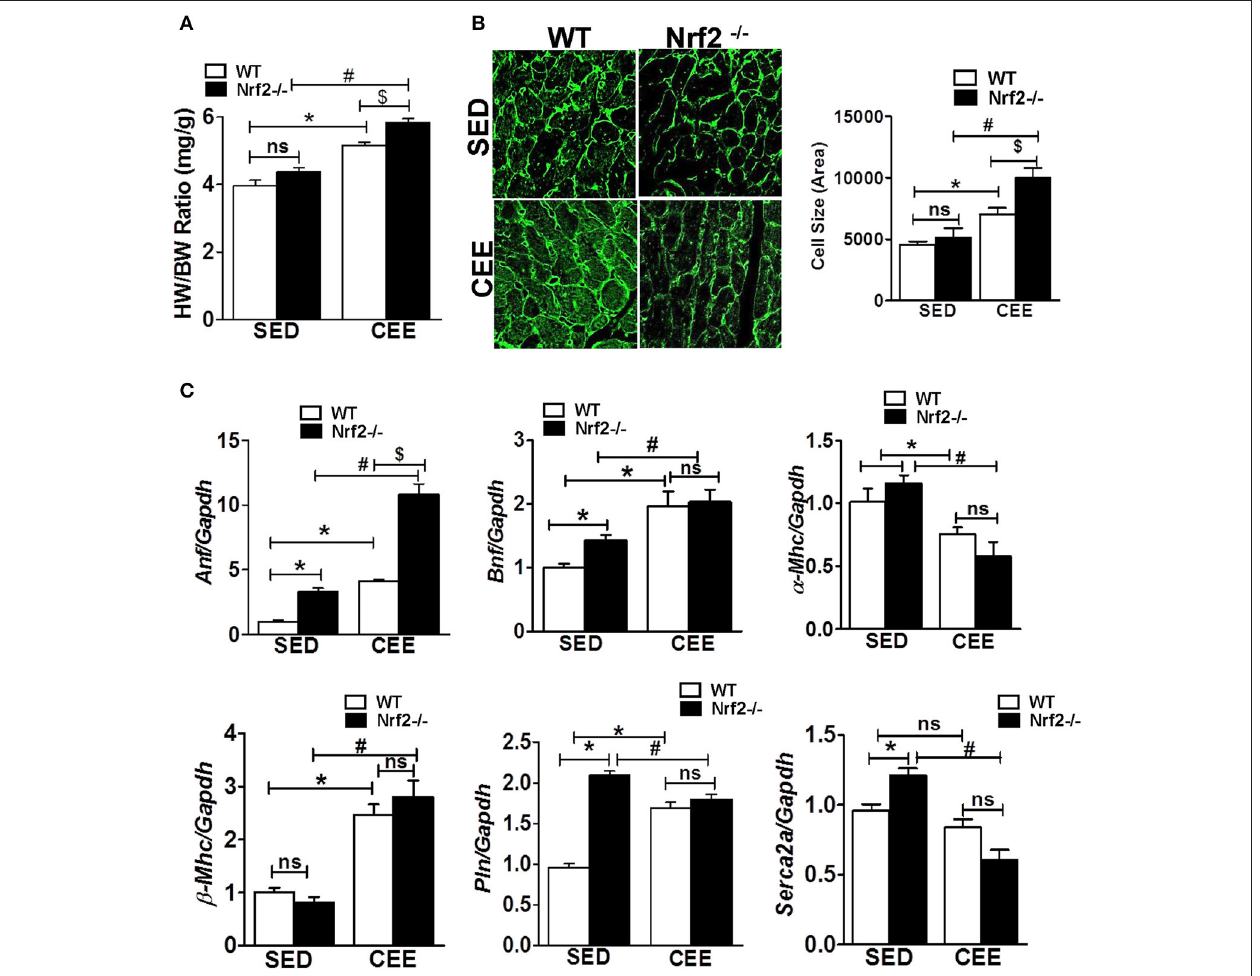
FIGURE 5 | Cardiac remodeling and myocardial hypertrophy gene expression in WT and Nrf2 − / − mice subjected to endurance exercise: (A) Heart weight/ body weight ratio was calculated from the data collected upon sacrifice, (B) heart cryosections were stained with wheat germ agglutinin (WGA) and imaged using Nikon eclipse at 20x magnification. Cell size was measured by quantifying the cardiomyocyte area using ImageJ software, ( n = 35–50 cells/group). (C) RT-qPCR was performed for hypertrophic gene markers ( Anf, Bnf, α -Mhc, β -Mhc, Pln, and Serca2a ) in sedentary and exercise mice (WT and Nrf2 − / − ). n = 4/group. Histograms show mean ± SD and statistical analysis was determined by one way ANOVA followed by Tukey multiple comparison tests (* P < 0.05 vs. WT-SED, # P < 0.05 vs. Nrf2 − / − -SED, $ P < 0.05 vs. WT CEE).